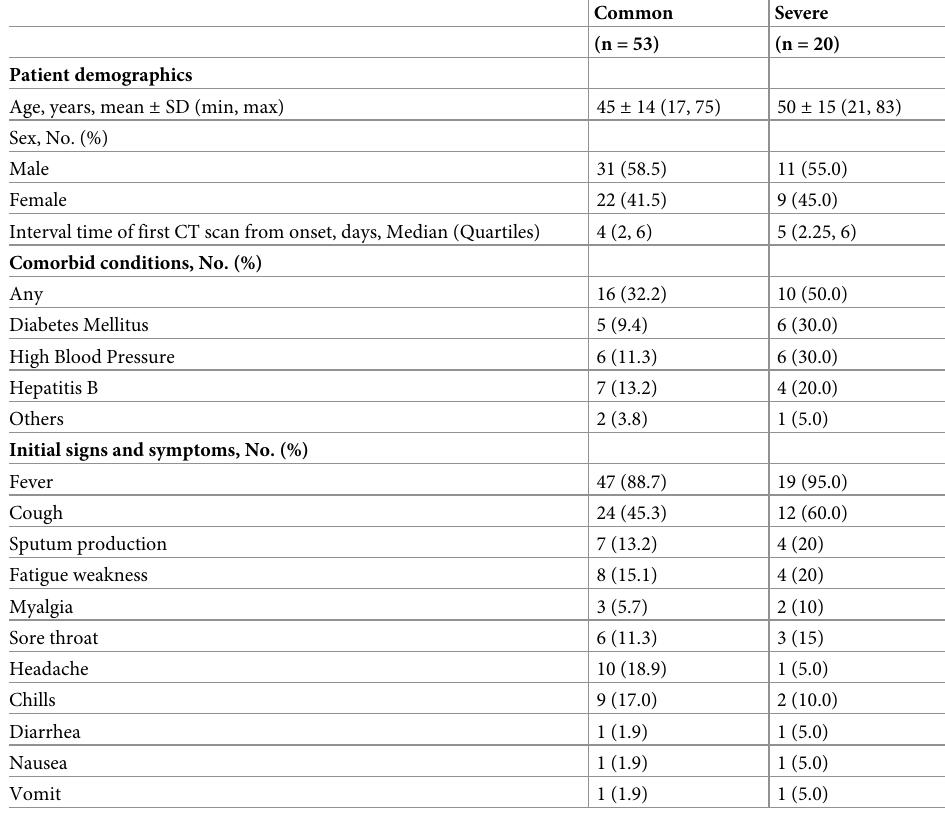
Table 1. Characteristics of patients with common and severe SARS-CoV-2 pneumonia.